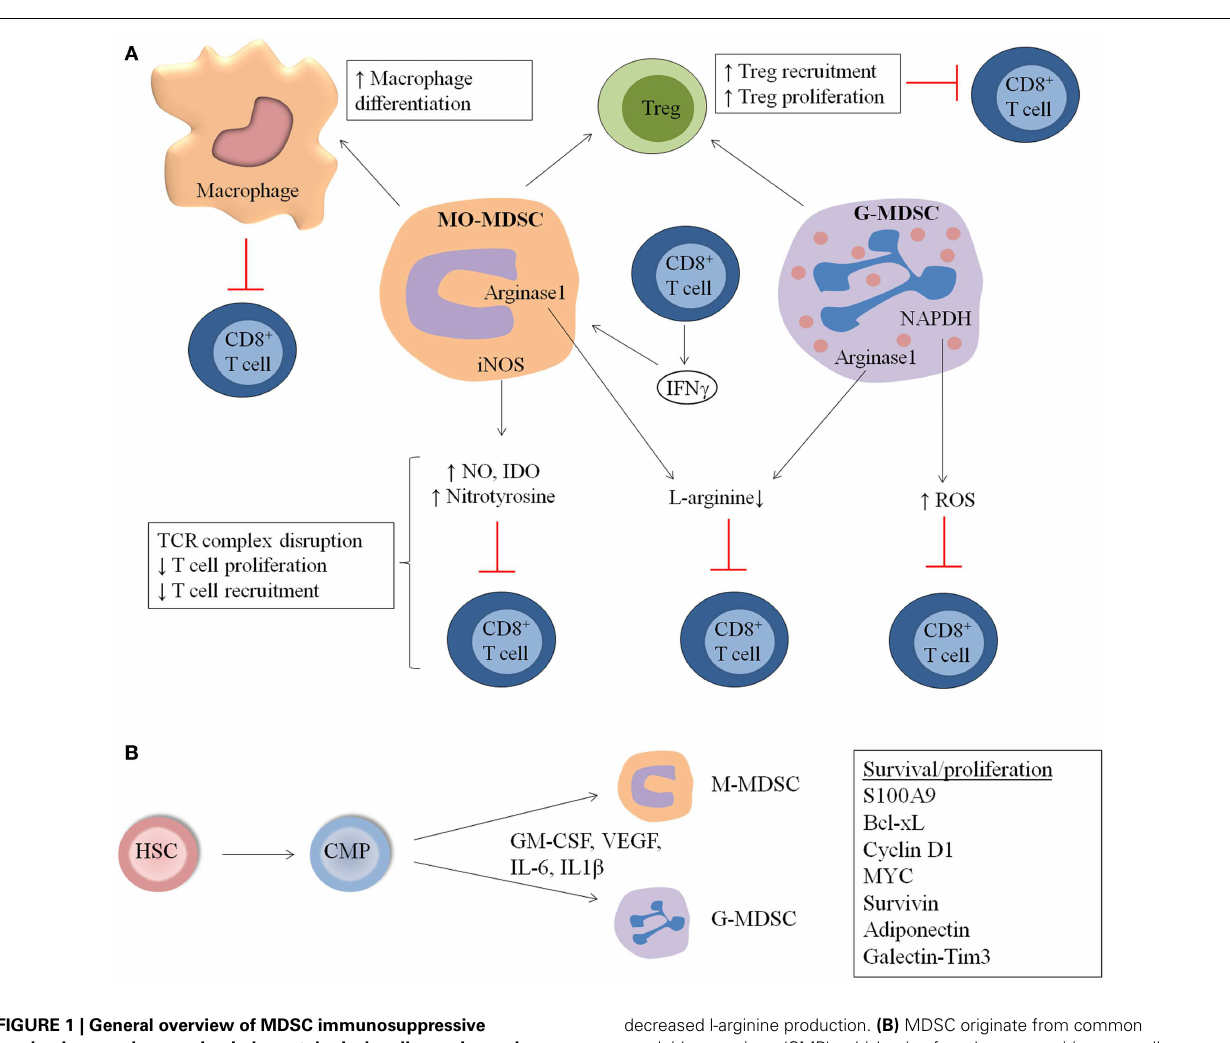
decreased l-arginine production. (B) MDSC originate from common myeloid progenitors (CMP), which arise from hematopoeitic stem cells (HSC). M-MDSC and G-MDSC are formed and proliferate in the presence of distinct factors including GM-CSF, IL-6,VEGF, and IL-1 β . Factors involved in the proliferation and survival of MDSC are S100A9, Cyclin D1, Bcl-xL Myc, and